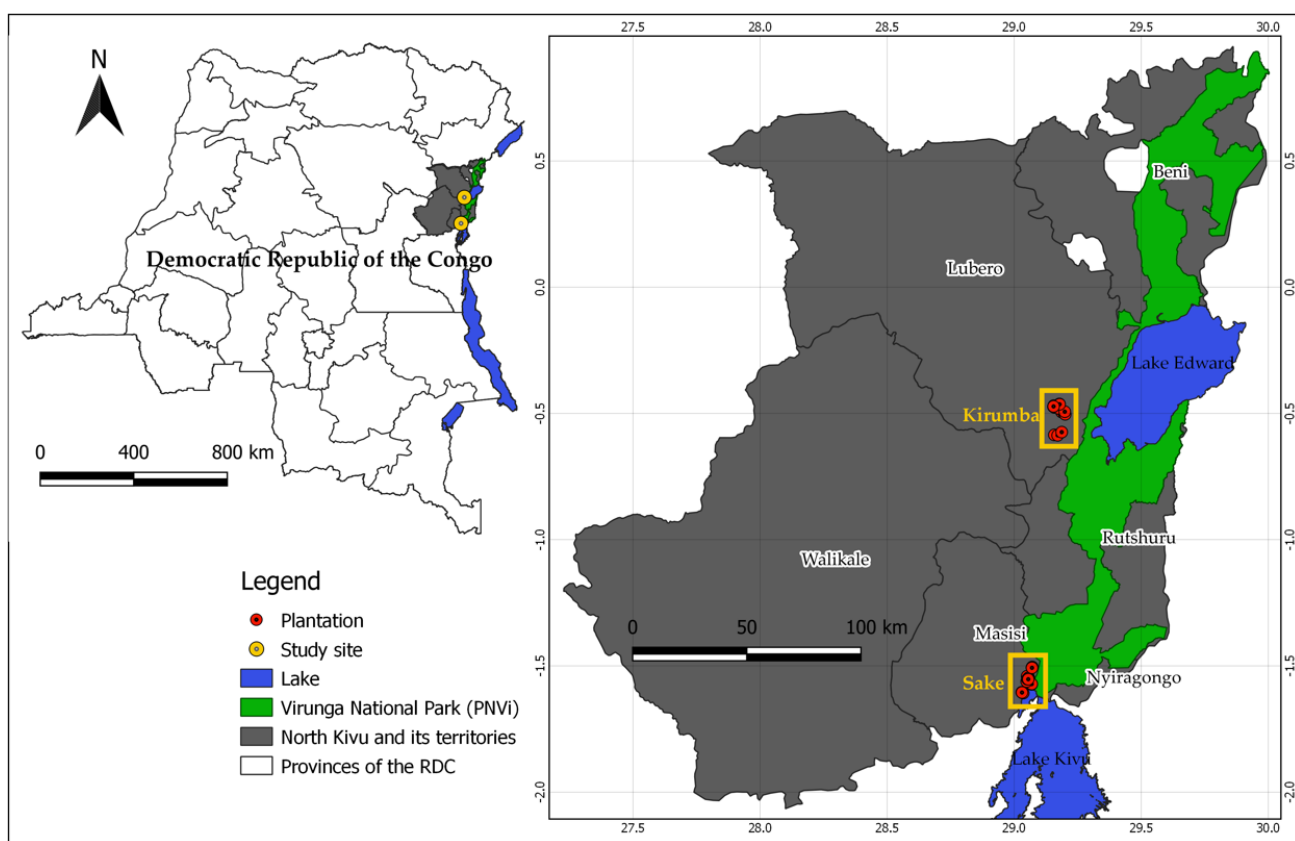
Figure 1. Location of the study sites and distribution of the plantations studied.